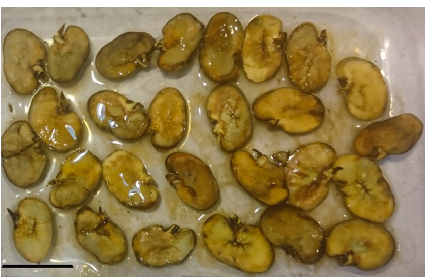
Figure 2: V. faba cotyledons treated with aqueous CuCl and placed flat side up. Scale